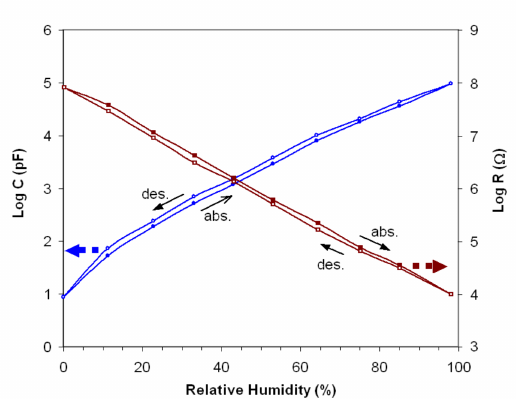
Figure 8. The absorption and desorption curves of both capacitive and resistive sensor.